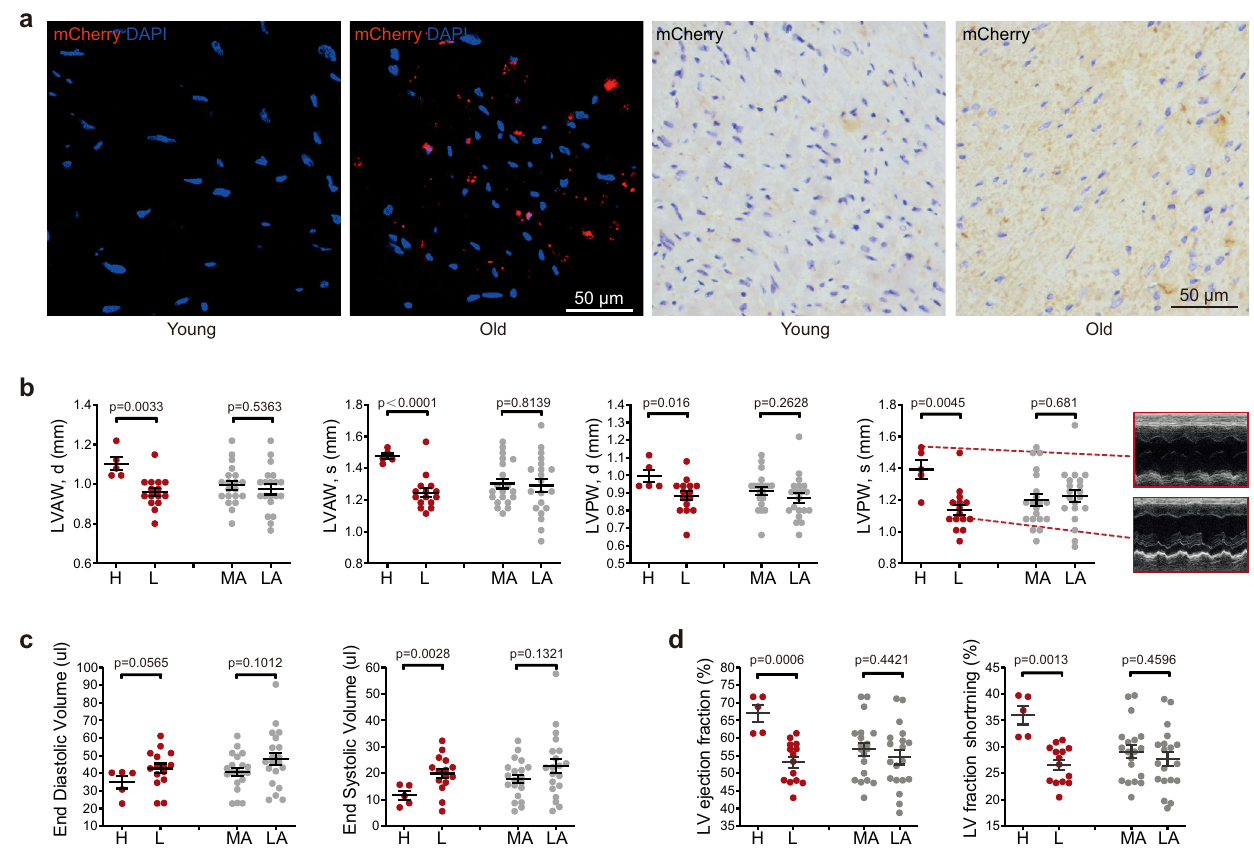
Fig. 5 | GAC signal correlates with cardiac aging and function decline. a RepresentativeimagesshowingmCherry fl uorescenceand anti-mCherrystaining in heart sections from young (3months,forIF and IHC) and old (23 months, for IF; 16 months, for IHC) Glb1 +/m mice. Scale bar, 50 µ m. b Comparison of thickness of systole/diastolic left ventricle anterior wall (LVAWs/d) and systole/diastolic LV posterior wall (LVPWs/d) between Glb1 +/m mice with high (H, n =5) and low (L, n =15)GACsignalandbetweenmiddle-aged(MA, n =20)andlate-aged(LA, n =20) Glb1 +/m mice, as determined by echocardiography. Representative